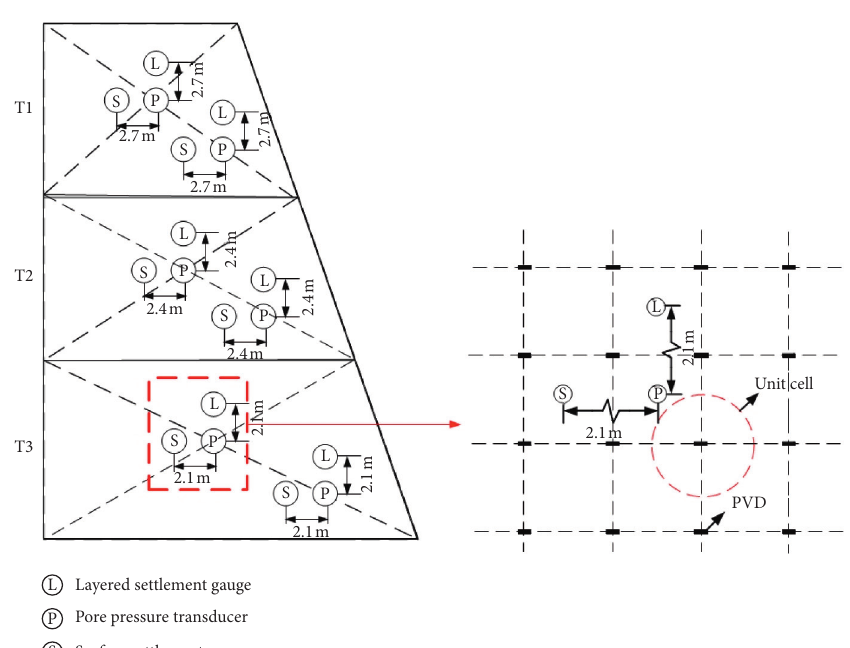
Figure 4: Layout of monitoring